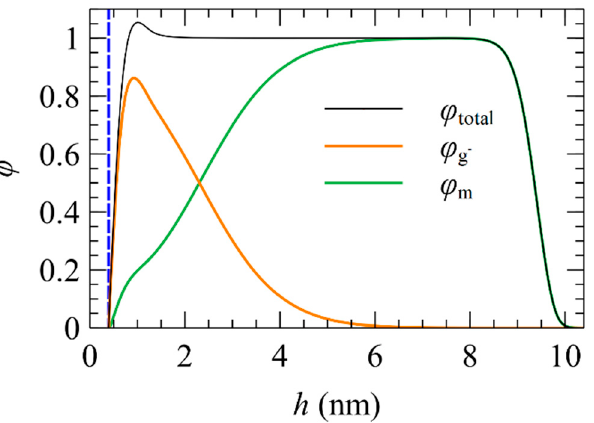
Figure 6. Total ( ϕ total ) and partial ( ϕ g , ϕ m ) density profile of a perfectly wetted SiO 2 /PS GMV system Figure 6. Total ( φ total ) and partial ( φ g , φ m ) density profile of a perfectly wetted SiO 2 /PS GMV system (see Table 1 in Ref. [27]), with σ g − = 0.4 nm –2 , N g − = 50, N m = 100, and L = 10 σ (see Table 1 in ref [27]), with = 0.4 nm –2 , = 50, N m = 100, and L = 10 nm. N − − g g